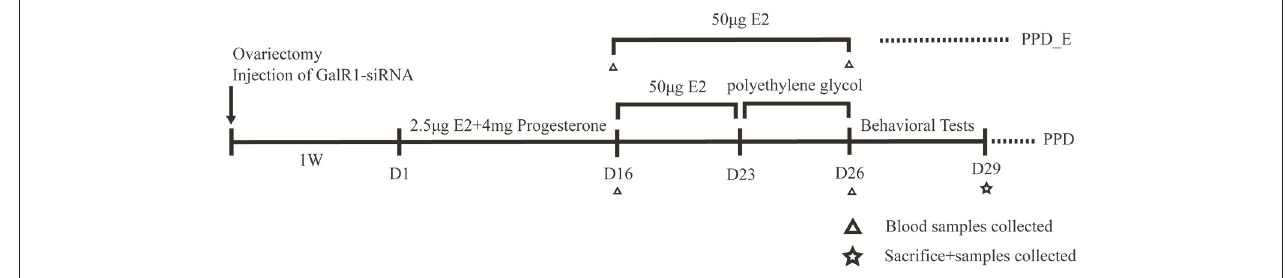
FIGURE 1 | Time schedule for the experiment. Behavioral tests included forced swimming test and sucrose preference